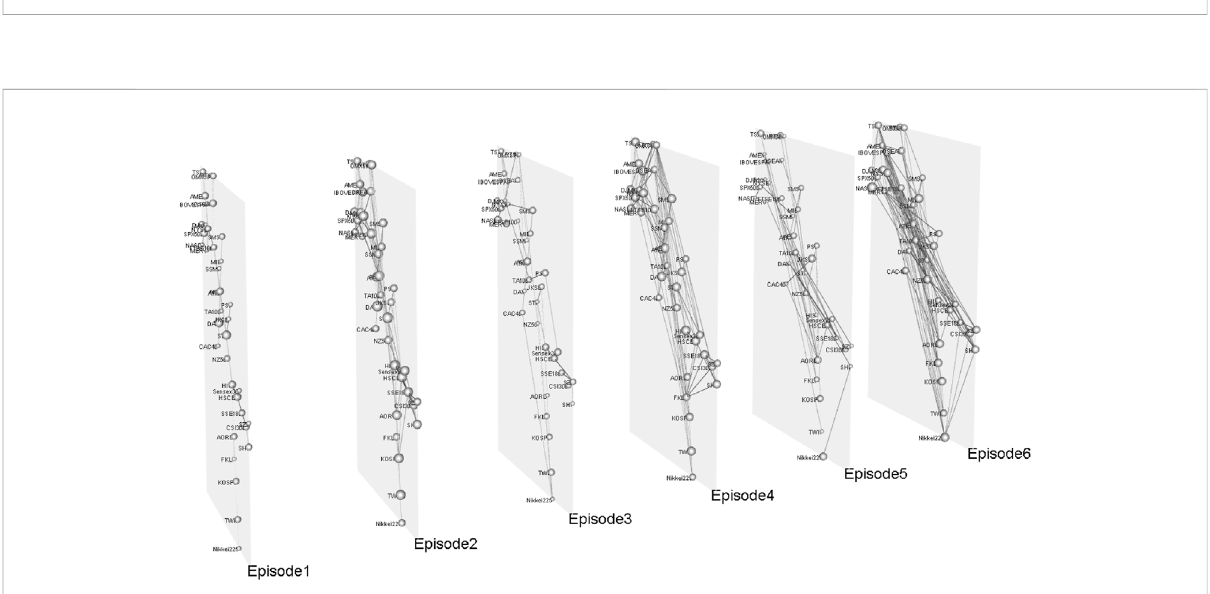
FIGURE 9 (Color online) Multilayer network at the time of European subprime mortgage